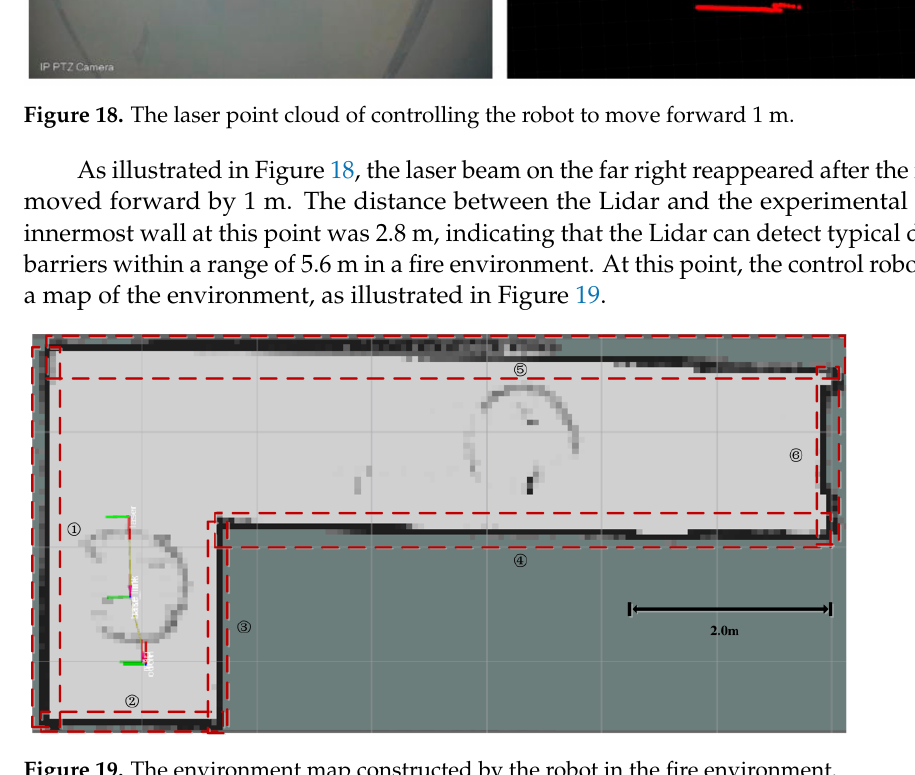
Table 2. Six edge errors of the map constructed by the robot in the